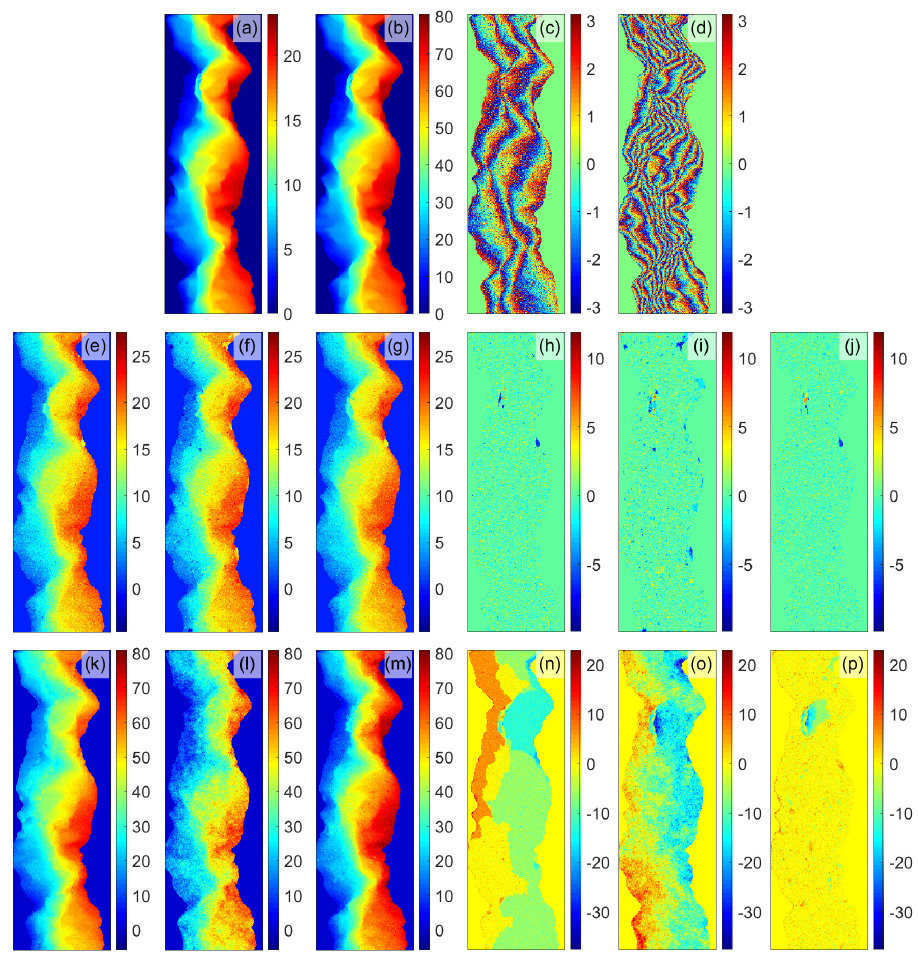
Figure 4. ( a , b ) Reference unwrapped phases (( a ) short and ( b ) long baseline length). ( c , d ) Simulated wrapped phases of ( a , b ). ( e – g ) PU results of ( c ) obtained by ( e ) SB L 1 -norm, ( f ) MB TSPA, and ( g ) MB LPM-TSPA. ( h – j ) Errors between ( a ) and PU results ( e – g ). ( k – m ) PU results of ( d ) obtained by ( k ) SB L 1 -norm, ( l ) MB TSPA, and ( m ) MB LPM-TSPA. ( n – p ) Errors between ( b ) and PU results ( k – m ). Table 2. Major Parameters of Simulated InSAR System and